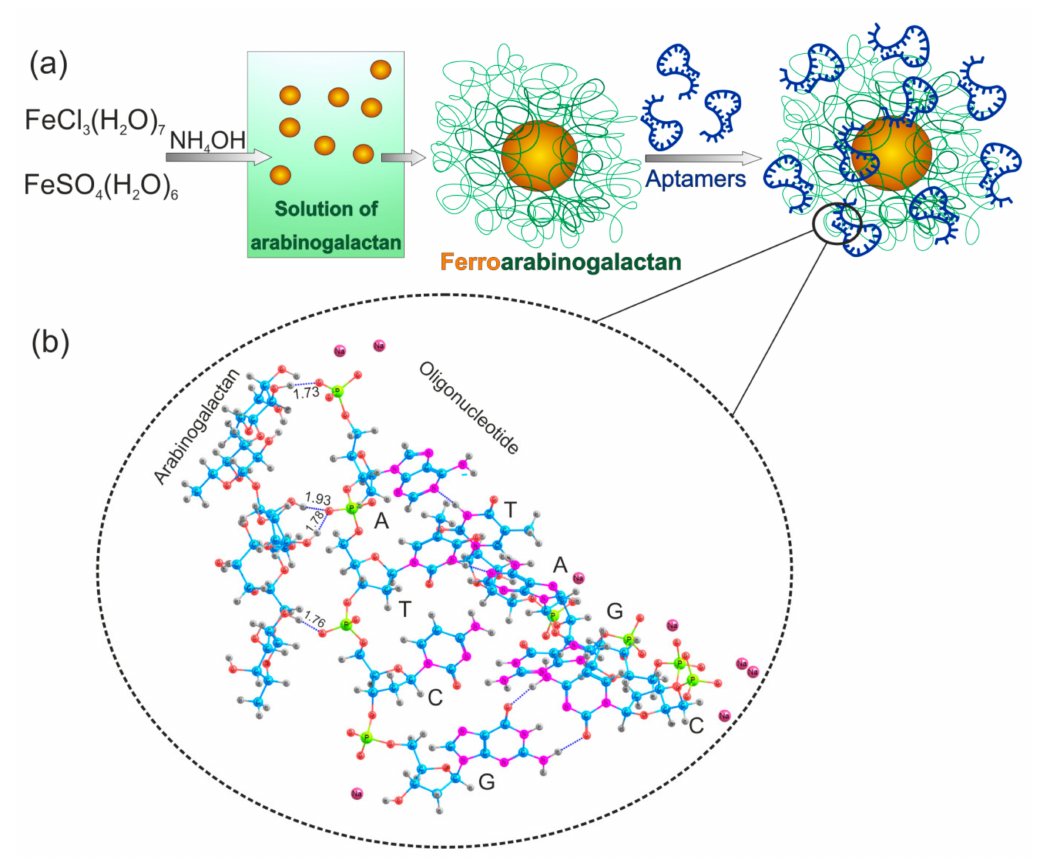
Figure 1. Synthesis of aptamer-conjugated ferroarabinogalactan nanoparticles (AS-FeAGs). ( a ) Schematic representation of the synthesis of ferroarabinogalactan nanoparticles and their conjugation with aptamers. ( b ) A part of the aptamer-arabinogalactan complex. C—Cytosine, G—Guanine, A—Adenine, and T—Thymine. Non-covalent hydrogen bonds between atoms are shown as blue dashed lines. Hydrogen—gray, oxygen—red, carbon—blue, nitrogen—purple, phosphorus—yellow,